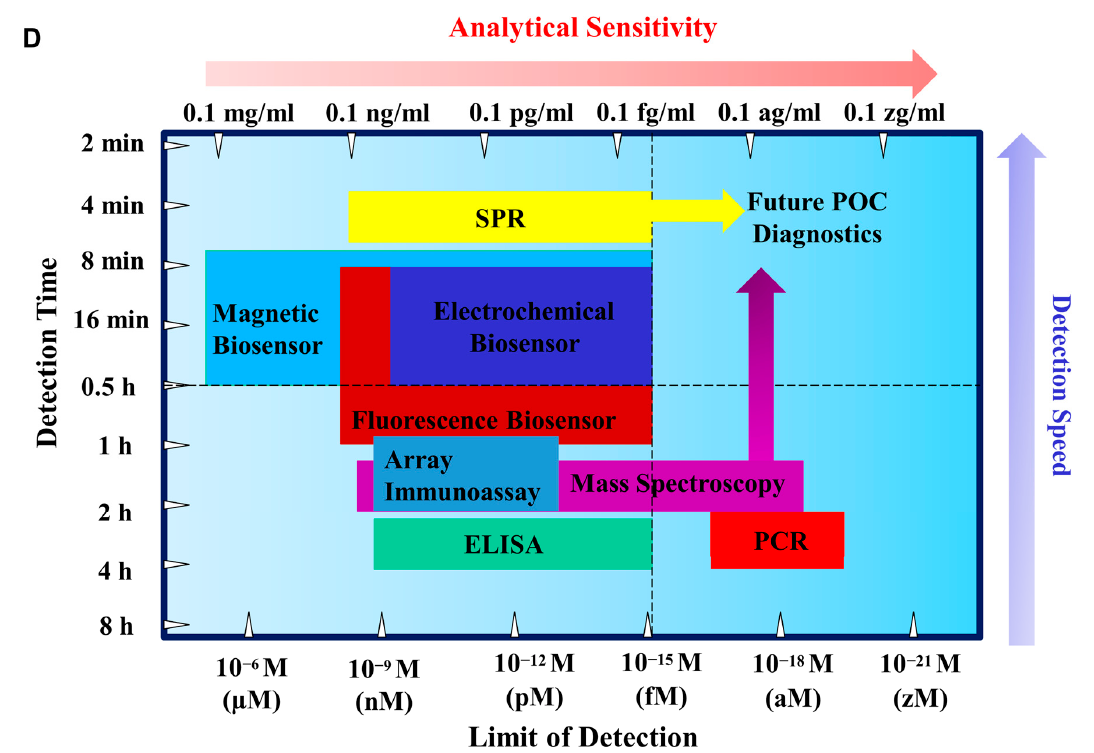
Figure 2. ( A ) Schematic representation of biosensors made of the following components: transducer, amplifier, processor, and display (created with Biorender.com). ( B ) A chip ELISA paired with a smartphone colorimetric diagnosis of ovarian cancer through urine is depicted in this diagram. A tiny quantity of urine was fed into the microchip on which sandwich ELISA was conducted. A cellphone’s installed camera was used to photograph the color generation in the chip. An integrated software device was used to measure the level of HE4 in urine. The pixel values from the designated region were recorded by the smartphone app. The level of the HE4 marker in each microchannel was estimated and shown on the device, relying on the regression of the calibration curves [62]. ( C ) Optical biosensor (surface plasmon resonance) was utilized to precisely identify HER2 proteins (in red) using a gold-coated fiber, with antibodies amplified in a sandwich arrangement (in green). To specifically target HER2, aptamers containing thiols are anchored on the surface. An optical fiber sensor is coupled to a spectrophotometer, and a laser source (480–720 nm) is shown in this schematic. The gadget is transportable and may be used with a laptop. A Gaussian surface plasmon resonance curve in PBS was generated using the gold-coated optical fiber [66]. ( D ) Schematic representation of comparison between the analytical sensitivity and detection time of different biosensing techniques.